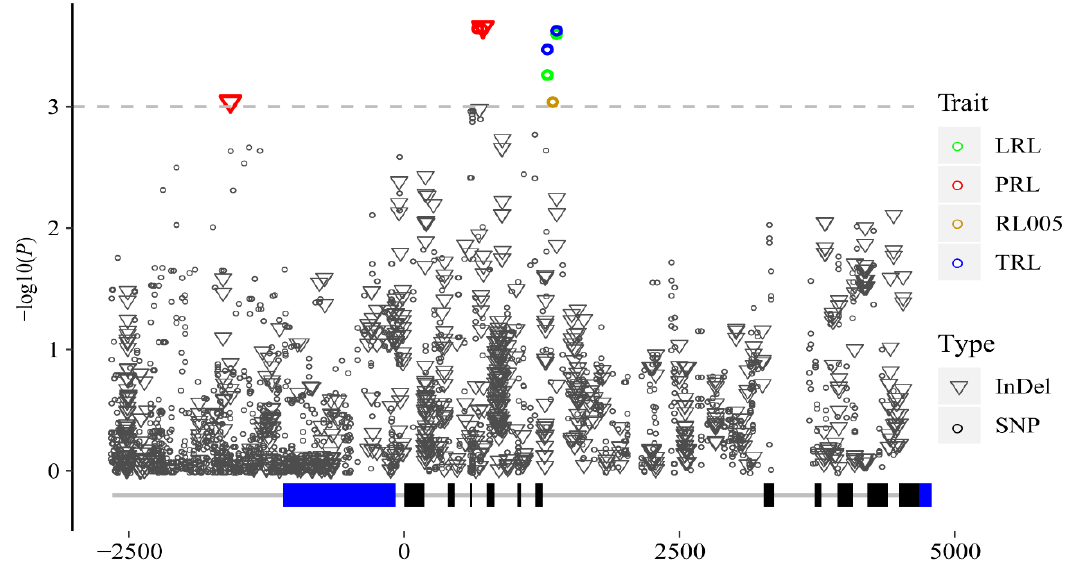
Figure 2. Gene-based association mapping. Manhattan plot using the mixed linear model. Triangles and dots represent InDels and SNPs, respectively. A schematic diagram of the genomic region of ZmMADS60, including upstream sequence and introns ( light gray ), the coding region ( black ), and 5’UTR and 3’ UTR ( blue ) is presented. Abbreviations for traits are as follows: LRL, lateral root length; PRL, primary root length; RL005, root length between 0 mm and 0.5 mm in diameter; TRL, total root length.